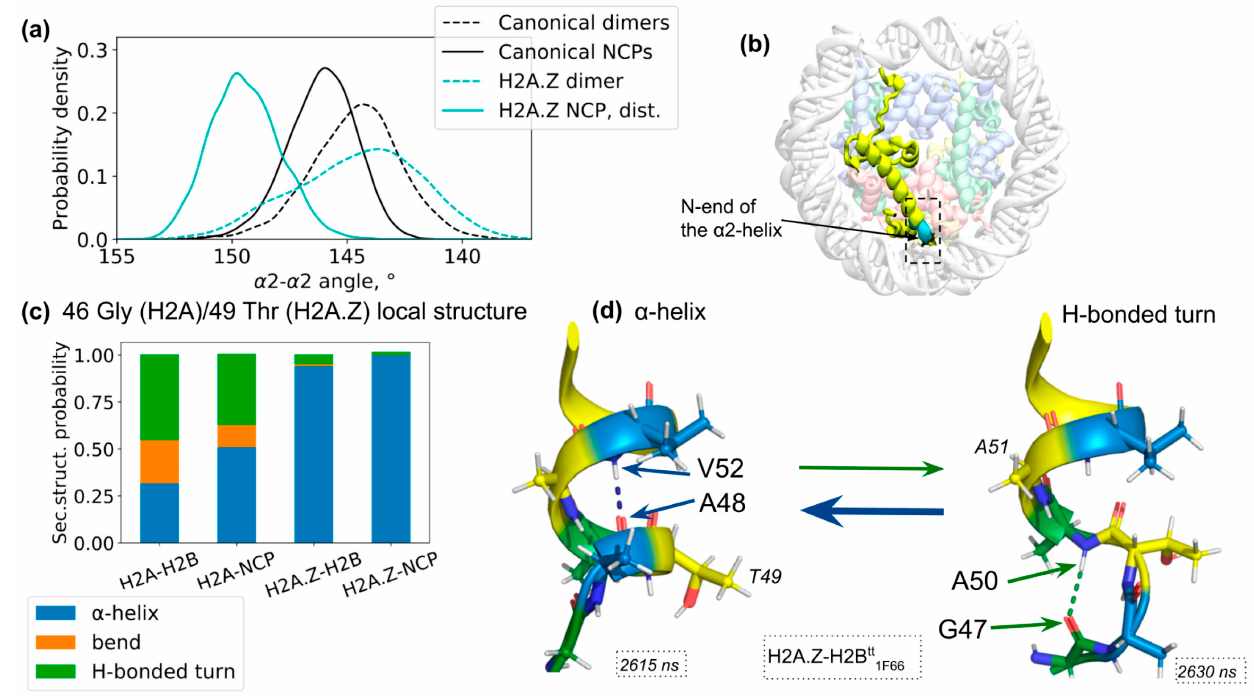
Figure 5. Effects of H2A.Z histone incorporation on the H2A.Z-H2B dimer and NCP dynamics. ( a ) α 2- α 2 angle distributions for canonical H2A-H2B and variant H2A.Z-H2B dimers free in solution and in the context of nucleosomes. ( b ) Location structural elements of H2A.Z histone in the context of nucleosome with particular emphasis on the changes at the N-end of the α 2-helix (substitutions of G46 and P48 in H2A to T49 and A51 in H2A.Z). ( c ) Probability of the N-end of the α 2-helix of